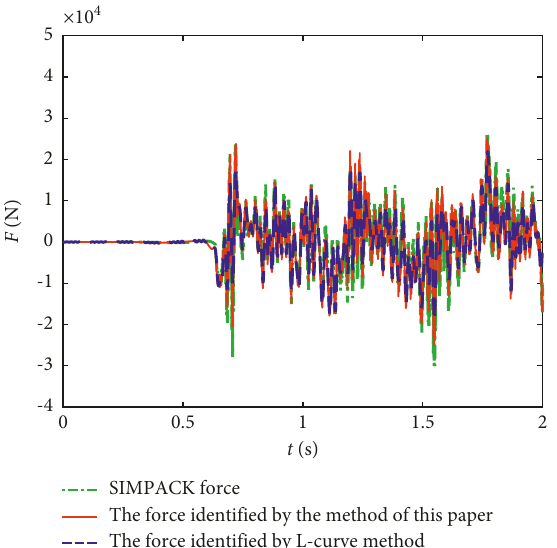
Figure 32: Amplitude-frequency curve of the two methods for F 4 identification when the noise level is